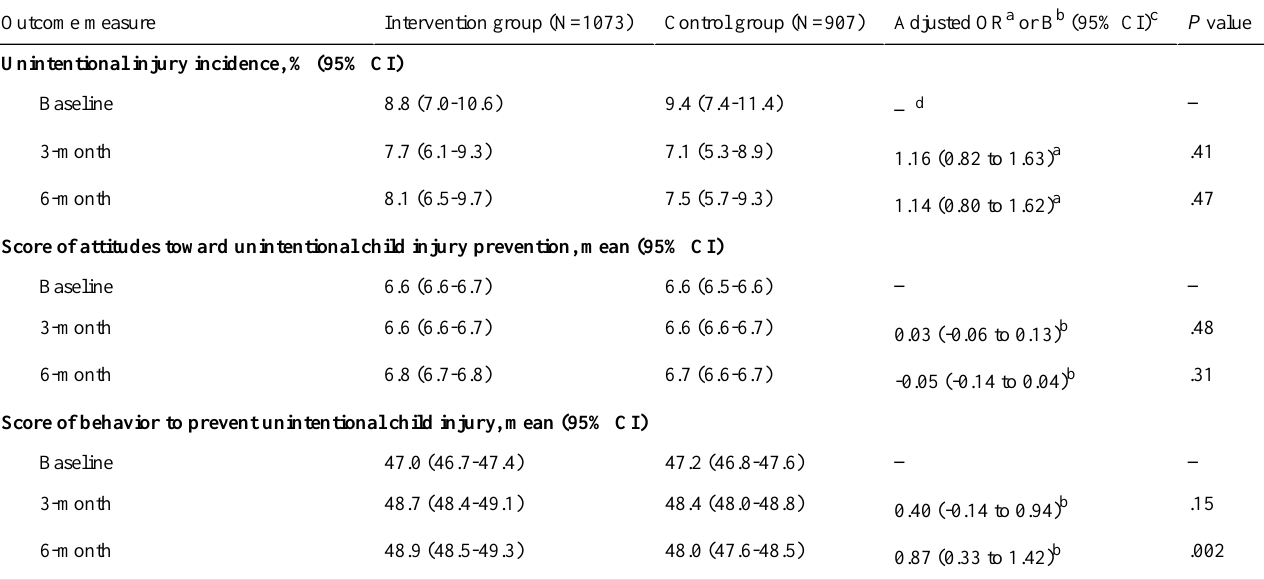
Table 2. Results for primary and secondary outcomes based on generalized estimating equations